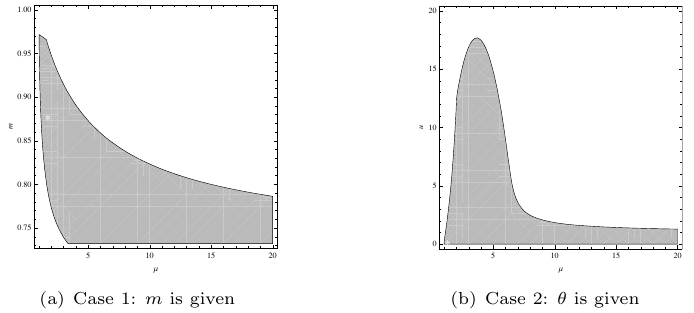
Figure 2. Regions for single curvature extremum for a C-shaped transition